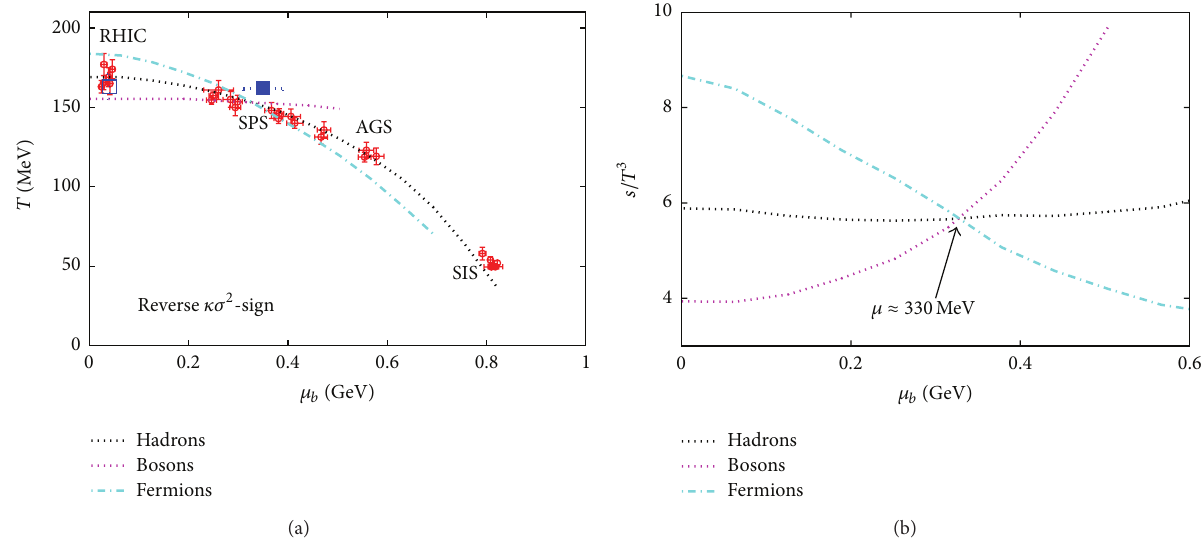
Figure 14: (a) illustrates the chemical freeze-out boundary. The experimental data are given by the solid circles. The curves represent the results of hadron, boson, and fermion gas determined when the sign of 𝜅𝜎 2 is flipped. (b) gives the corresponding 𝑠/𝑇 3 values. The lattice QCD endpoint is marked by solid